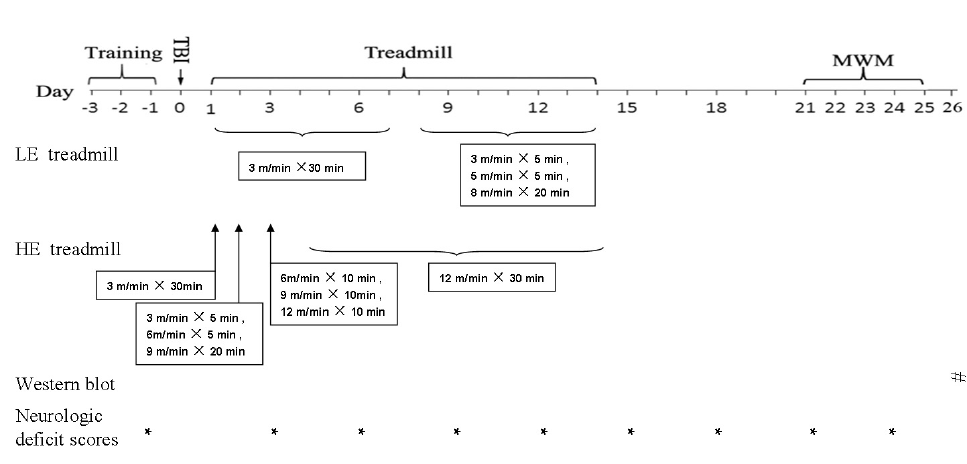
Figure 8. Schematic illustration of the experimental design. Treadmill training was performed prior to surgery for 3 consecutive days. On day 1 after the CCI operation, rats in the HE and LE group were subjected to the treadmill exercise until day 14. * Represent the neurological deficit scores testing days. # represents the days when rats were sacrificed to obtain measurements of protein (Western blot). Evaluation of spatial learning using the Morris water maze started on day 21 and continued each day until day 24 post CCI. Spatial memory was evaluated on day